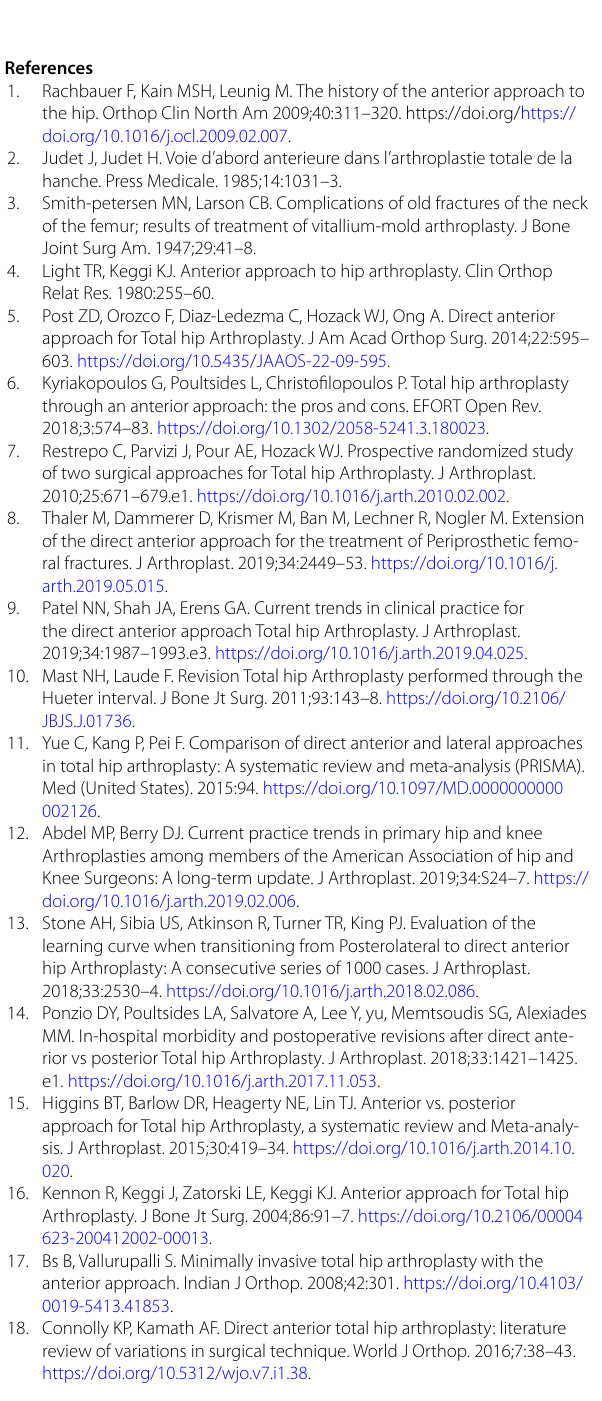
table -a prospective cohort study. BMC Musculoskelet Disord. 2017;18:1– 9. https:// doi. org/ 10. 1186/ S12891- 017- 1427-2. 30. Bechler U, Springer B, Boettner F. Anterior primary Total hip Arthroplasty. Total hip replace. - an Overv. InTech. 2018. https:// doi. org/ 10. 5772/ intec hopen. 76070. 31. Vandeputte FJ, Vanbiervliet J, Sarac C, Driesen R, Corten K. Capsular resection versus capsular repair in direct anterior approach for total hip arthroplasty: a randomized controlled trial. Bone Joint J. 2021;103-B:321–